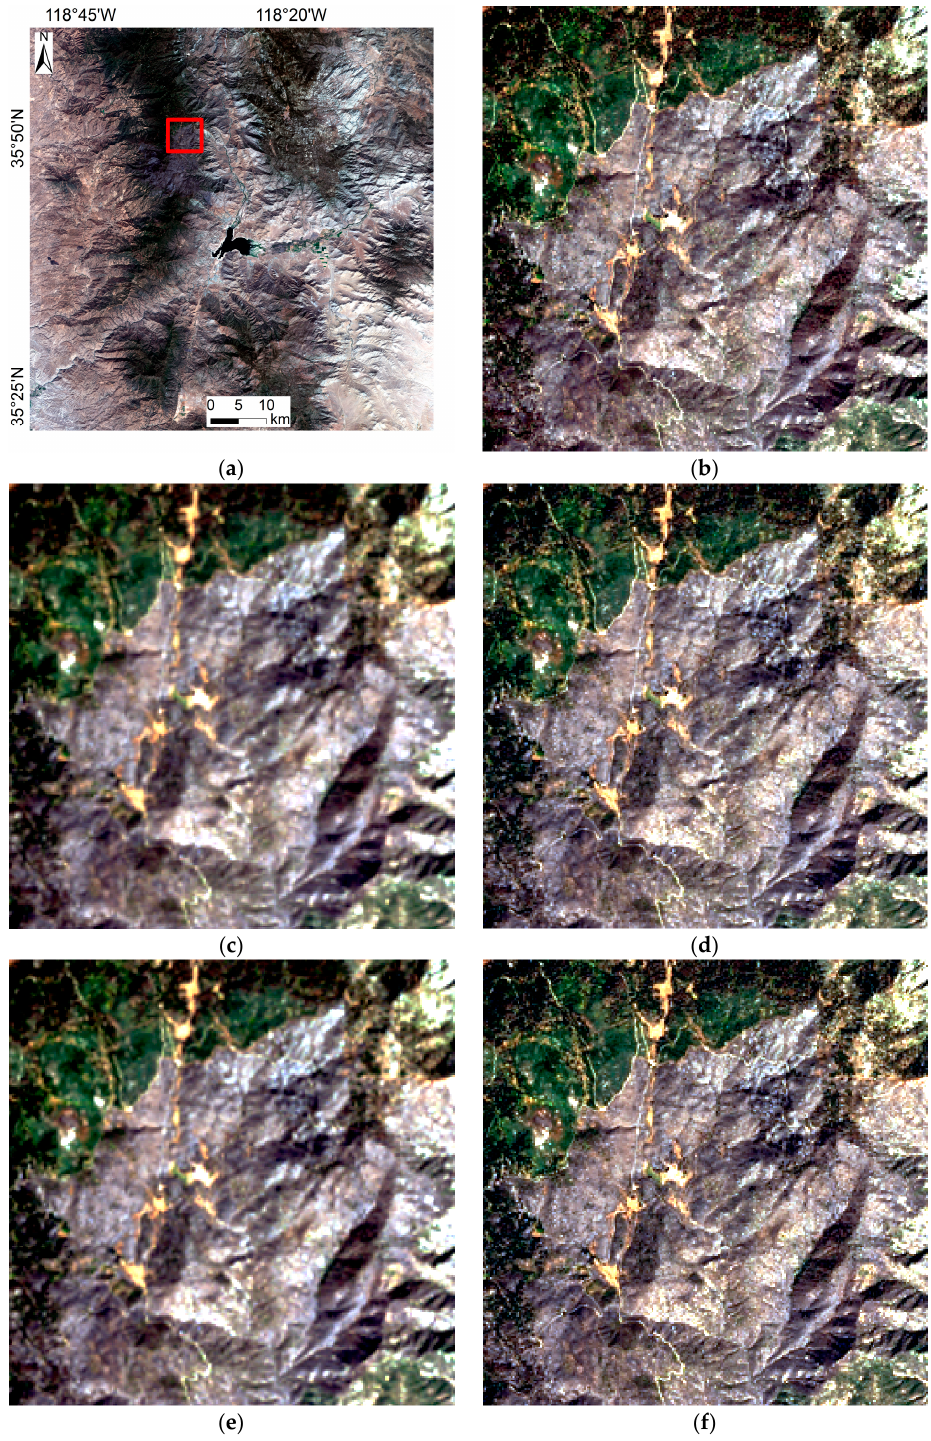
Figure 6. Burned forest area, California, true color images showing: ( a ) Sentinel-2A 20-m image (3600 × 3600 20-m pixels) and sub-set (red box); ( b ) Sentinel-2A 256 × 256 20-m pixel sub-set; ( c ) Landsat-8 bilinear resampled to 20 m; ( d ) Landsat-8 bilinear-based LPAD 20-m data; ( e ) Landsat-8 cubic convolution resampled to 20 m; ( f ) Landsat-8 cubic convolution-based LPAD 20-m data.